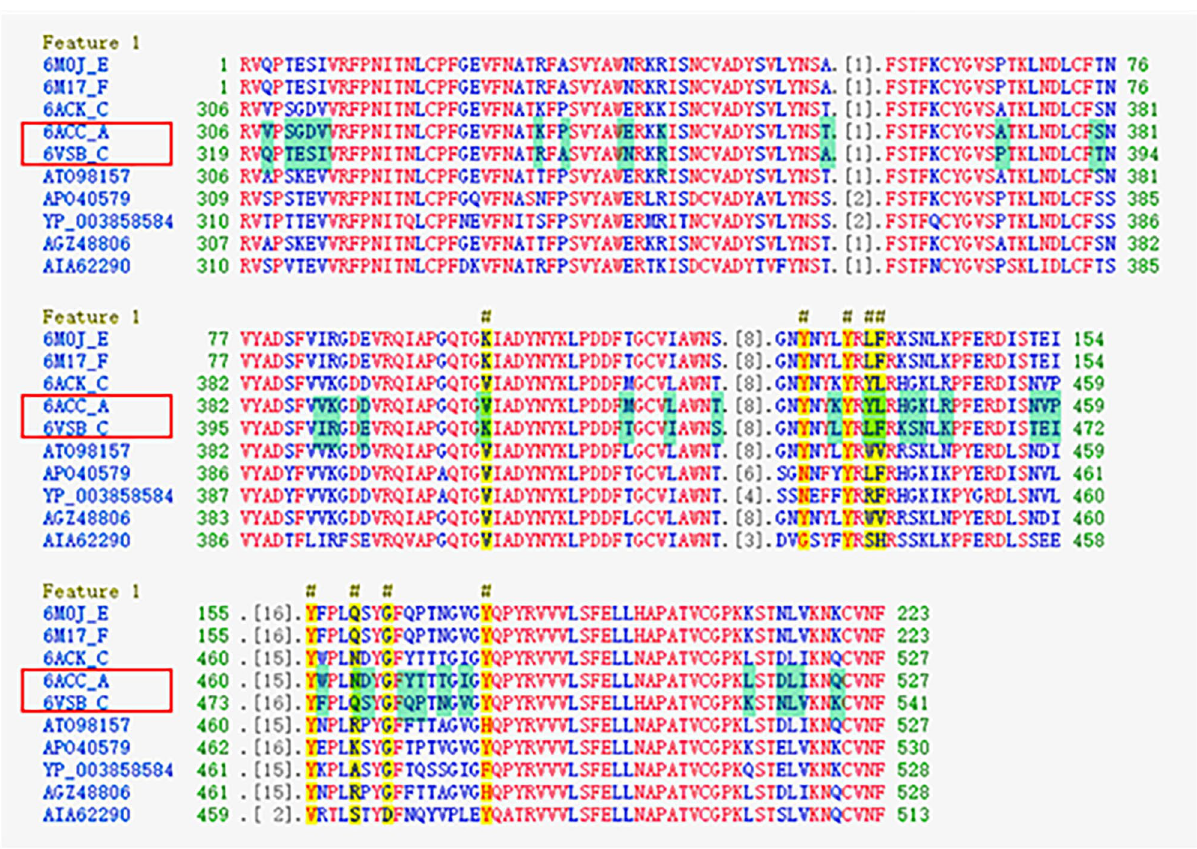
Table 1. The protein domain conservation and variation for sequences of SARS-CoV-like_Spike_S1_RBD subfamily of cd21477 in NCBI. In sequence, red font indicates highly conserved, blue for less conserved and gray for unaligned as the threshold 3.5 for conservation alignment. Green background indicates amino acid differences between 6ACC-A for SARS-CoV and 6VSB-C for